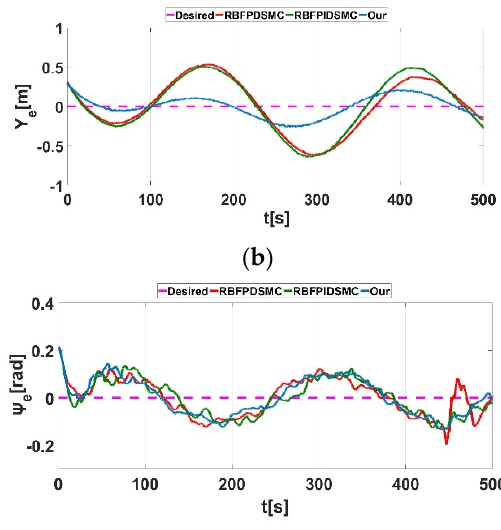
Figure 16. Three − dimensional view of the trajectory.